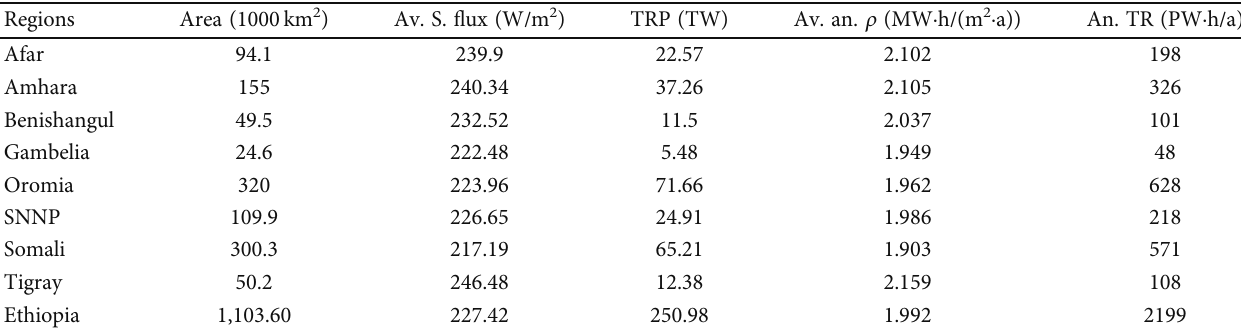
Figure 8: Annual total solar energy fl ux per unit area, solar average annual fl ux density (MW · h/(m 2 · a)), and total reserve power in TW of di ff erent regions in Ethiopia. Table 3: Solar energy resource in di ff erent regions of Ethiopia.